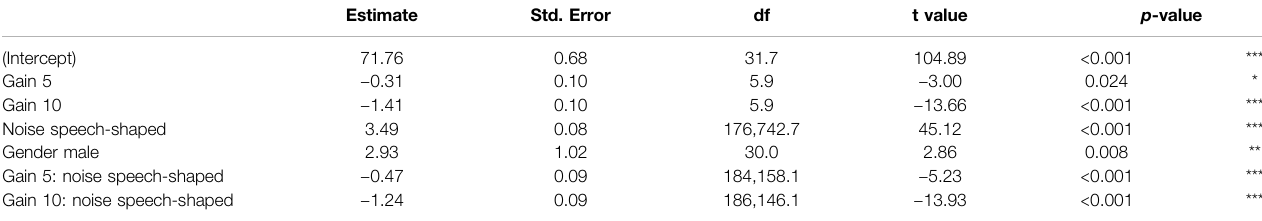
TABLE 3 | LME models fi t by REML for the response variable SPL and the fi xed factors 1) gain, 2) noise, 3) gender, and the interaction between gain and noise. Estimate Std.